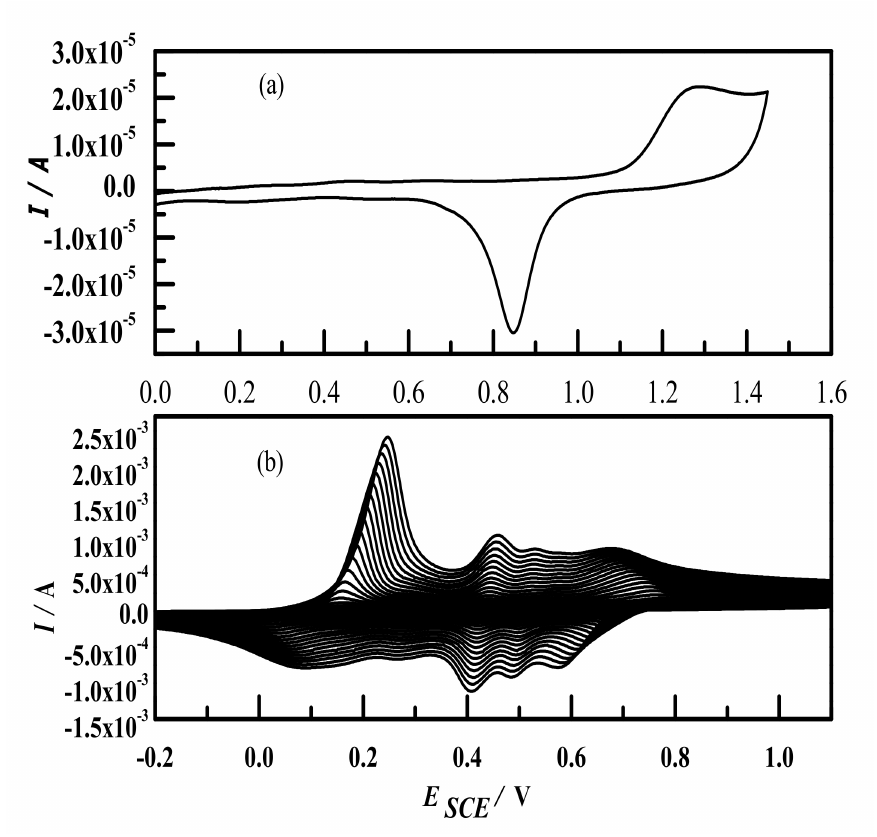
Figure 1. ( a ) Cyclic voltammogram of gold disc electrode recorded in 0.5 M sulphuric acid solution at 50 mV/s. ( b ) Cyclic voltammogram of gold disc electrode recorded during electrolysis of a solution containing 1 m M 2-hydroxyaniline and 20 m M aniline in 0.5 M sulphuric acid solution at 50